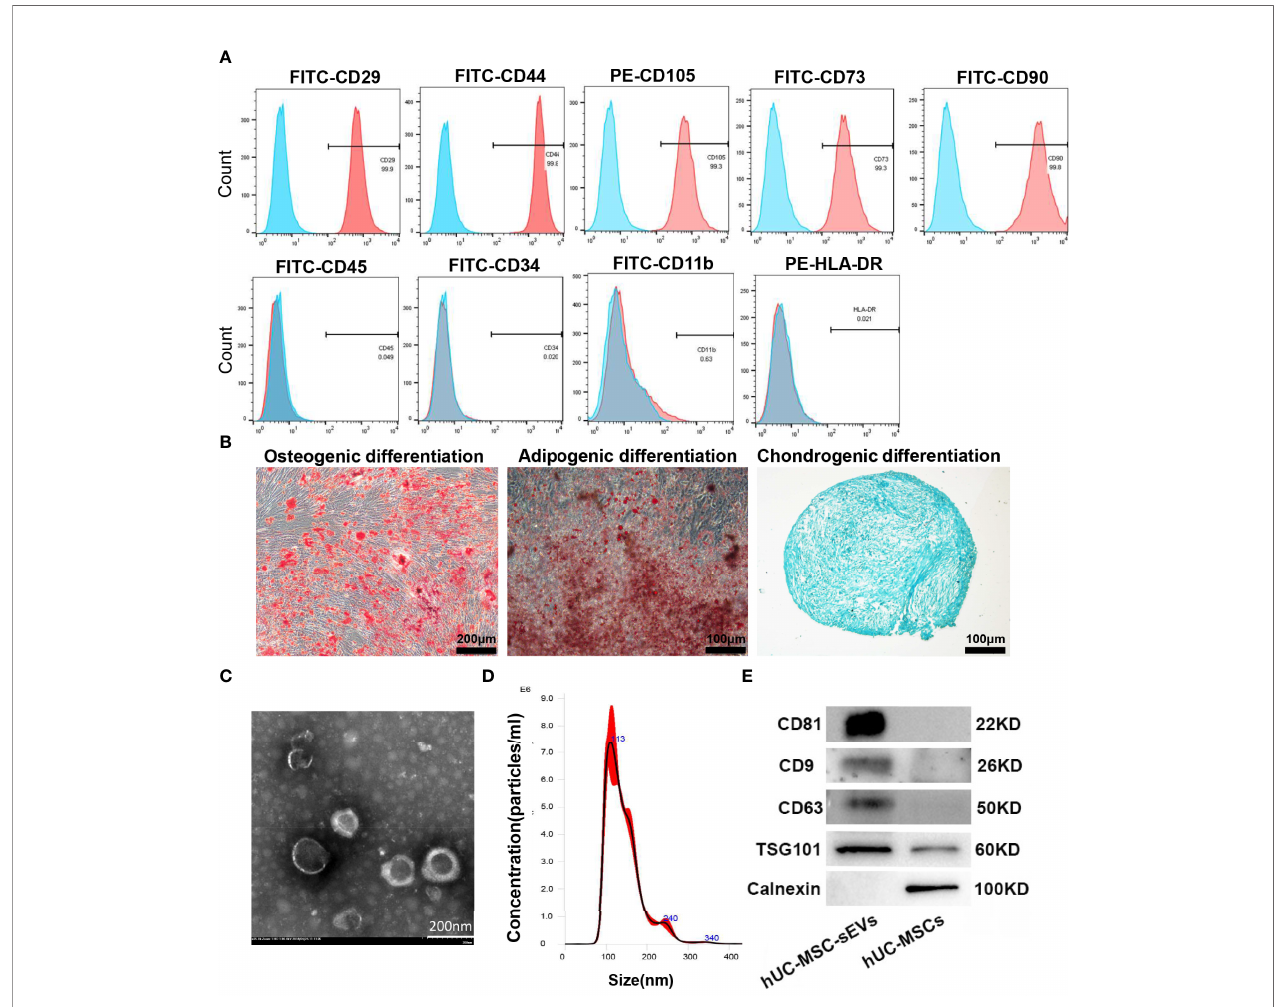
FIGURE 1 | Characterization of hUC-MSCs and hUC-MSC-sEVs. (A) Flow cytometry analysis for the immunophenotypic surface markers (CD29, CD44, CD105, CD73, CD90, CD45, CD34, CD11b and HLA-DR) of hUC-MSCs. Blue histograms represent the isotype controls, and the red solid peak represents the marker indicated. (B) Representative images of osteogenic (alizarin red S staining), adipogenic (Oil Red O staining) and chondrogenic (Alcian Blue staining) differentiation assay. (C) Representative transmission electron micrograph of hUC-MSC-sEVs. (D) Nanoparticle tracking analysis for measurement of hUC-MSC-sEVs size. (E) Western blotting of marker proteins (CD81, CD9, CD63, TSG101 and Calnexin) in hUC-MSC-sEVs and